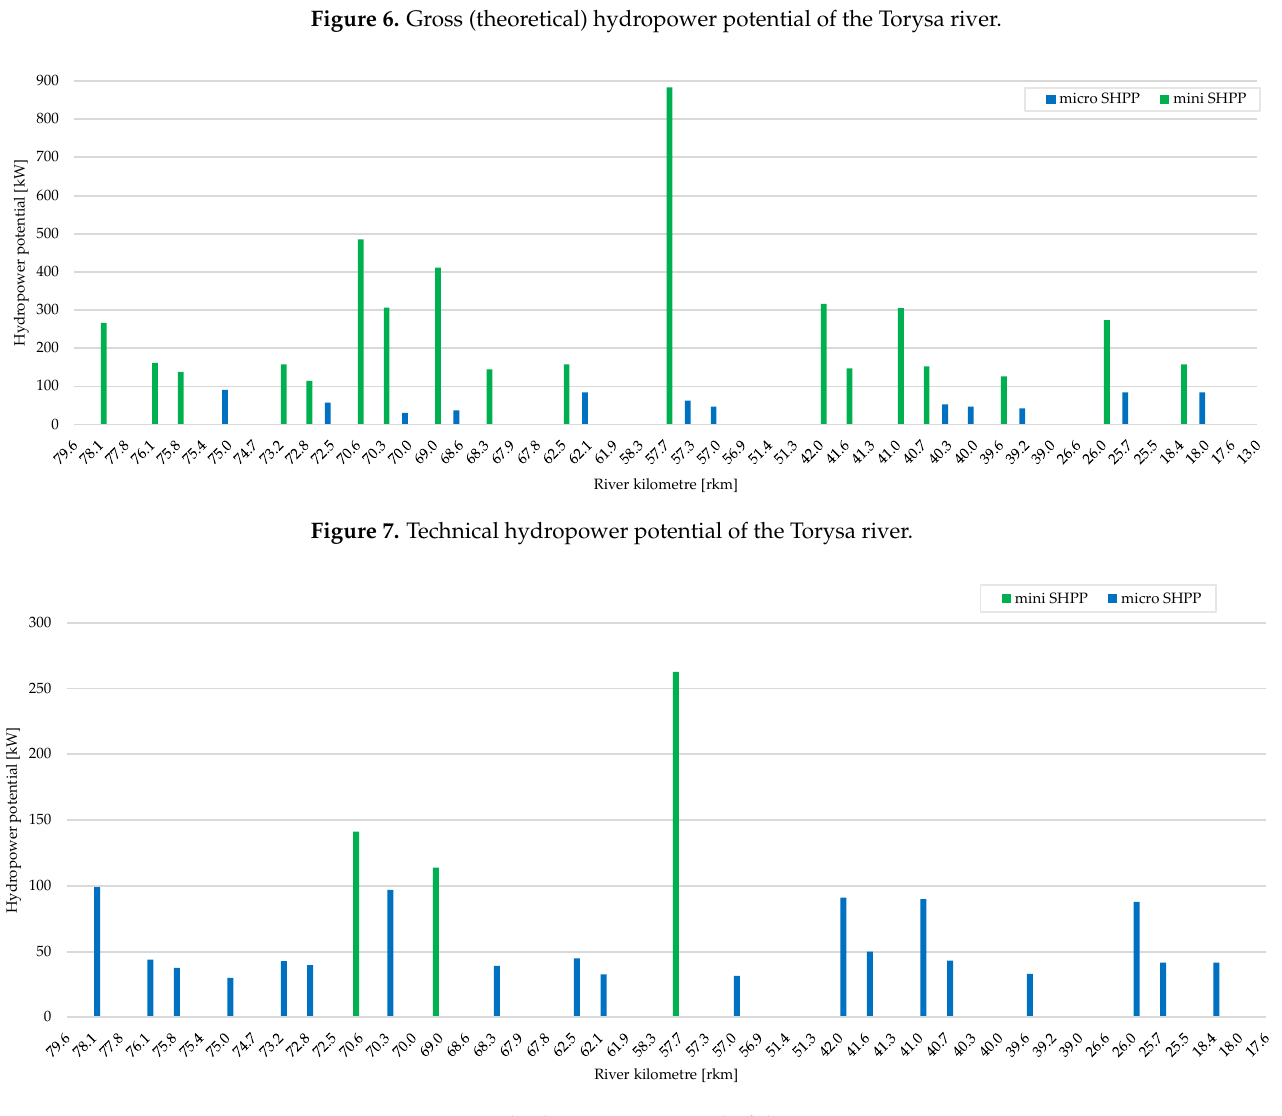
Figure 8. Economic hydropower potential of the Torysa river.